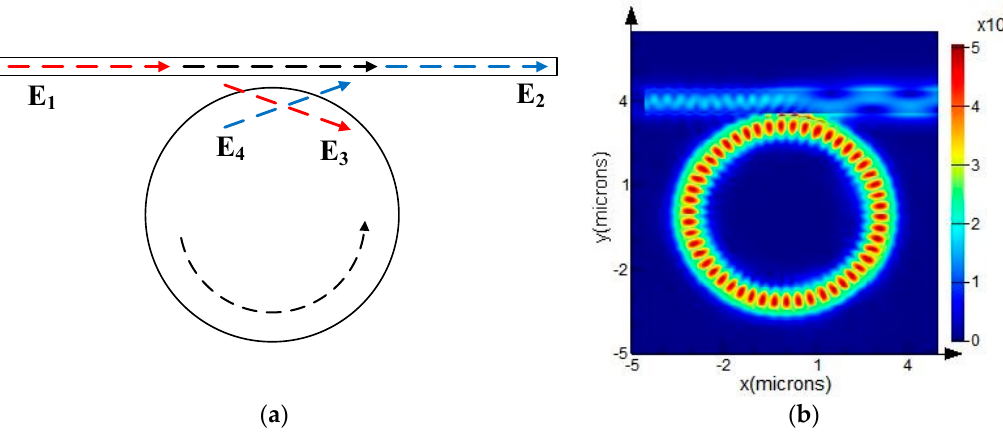
Figure 5. Model of the WGM resonator: ( a ) geometric optical mode; ( b ) optical field distribution.